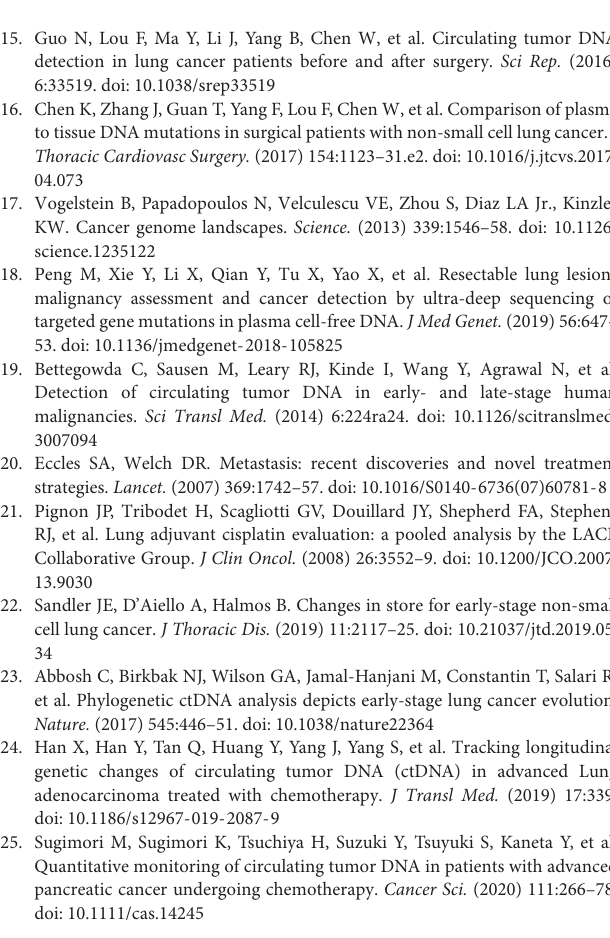
FIGURE S1 | The most frequently detected mutations in tumor tissue and ctDNA. TABLE S1 | 127 gene panel. TABLE S2 | Plasma ctDNA detection indices at each time point for all patients.